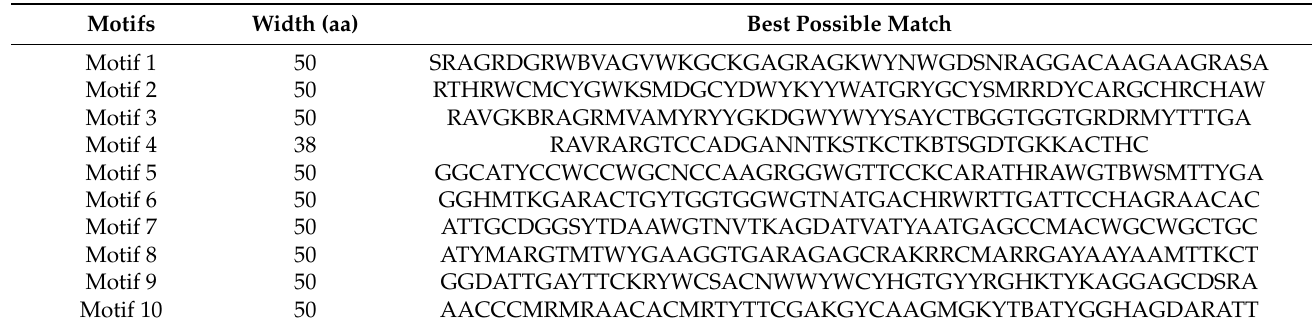
Table 3. HSP70 motif sequences identified in A. sinensis by MEME